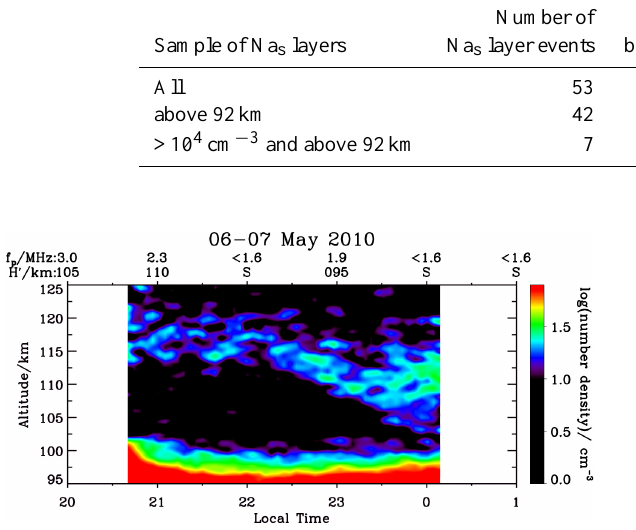
Figure 8. Na density contour plot and E s layer parameters during the night of 6–7 May 2010, which displayed a high-altitude Na s layer above 105km. Notice the E s layer did not occur during the entire observation of the Na layer.